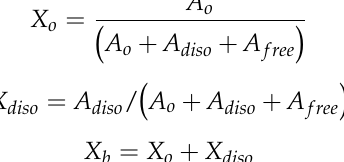
Figure 11. FTIR spectra at the region of 4,000–500 cm −1 for unaged and aged polyurea.